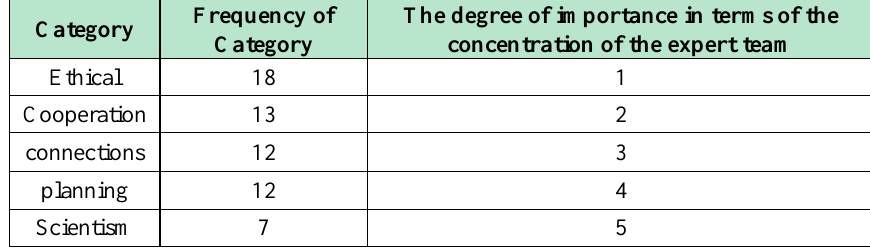
Table 5: Rating of the importance of executive